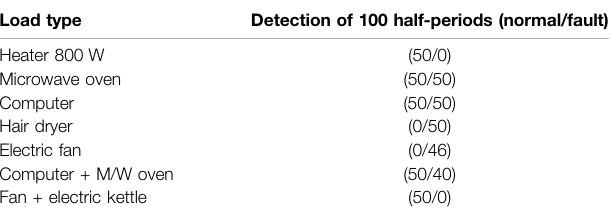
TABLE 2 | Statistics of arc fault detection results ( d 2